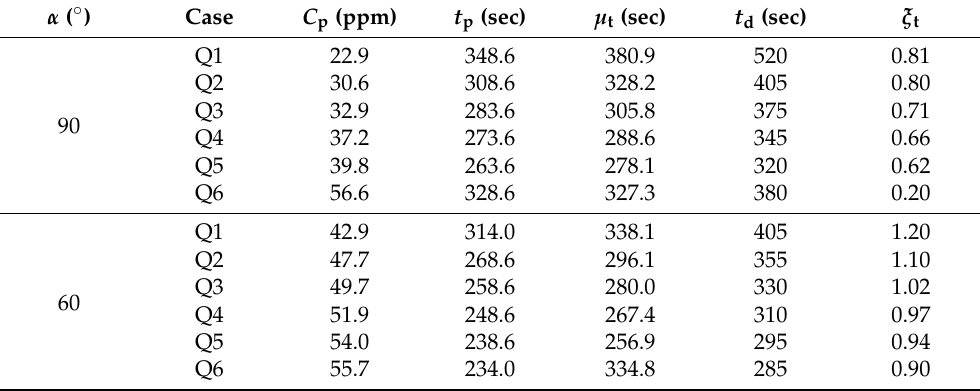
Figure 8. Concentration distributions when the peak concentration occurs in the recirculation zone. Table 2. Statistical properties of C-t curves at x = l s /2, y = b s /2 ( C p : peak concentration; t p : time for occurrence of C p ; µ t : centroid of the C-t curve; t d : retention time of the contaminated water; ξ t : Skewness